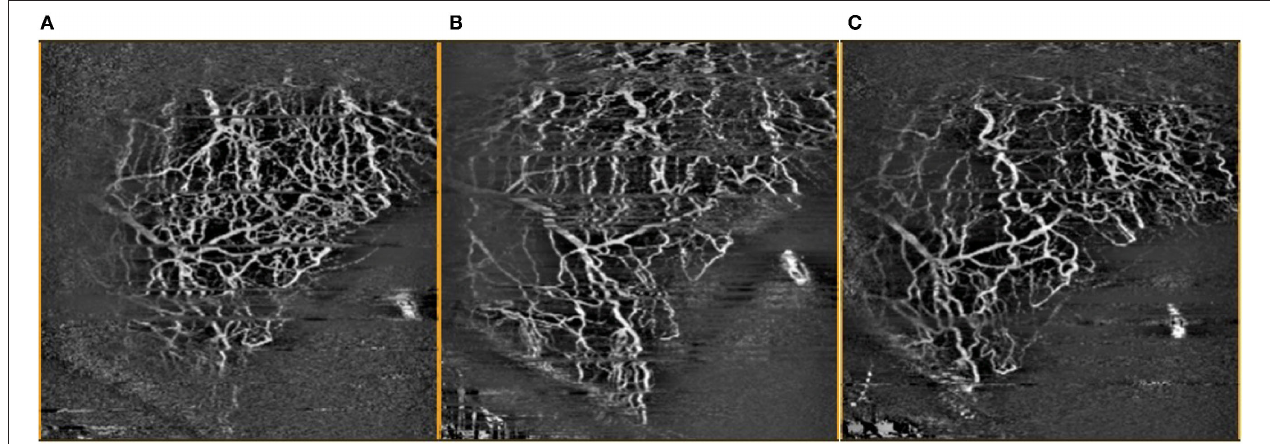
FIGURE 4 | Comparison of OCTA images of inferior temporal episcleral vessels taken (A) pre-operatively, (B) 1 month post-operatively, and (C) 3 months post-operatively, with artefacts removed.